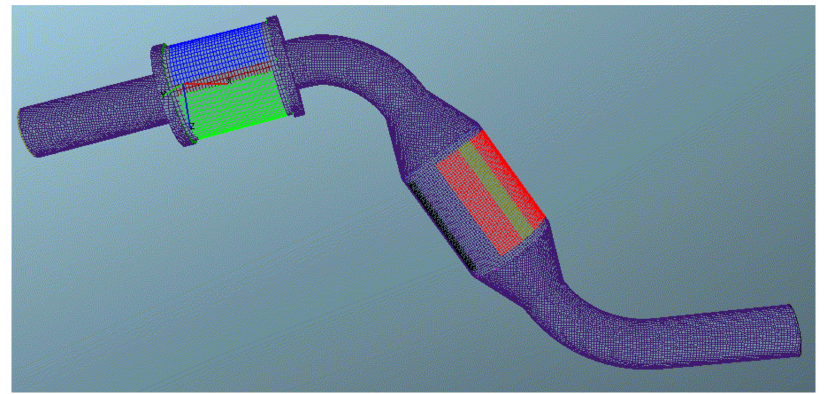
Figure 3. The computational mesh of the ICE exhaust